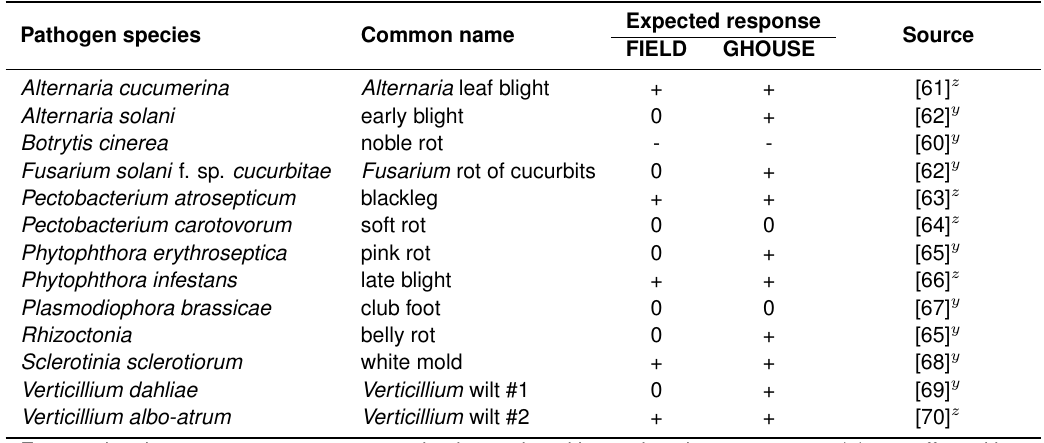
Expected pathogen responses are categorized as reduced in number due to treatment (+), not affected by treatment (0) or stimulated by treatment (-). All cited studies measured pathogen response at temperatures equal to or less than those achieved at 10 cm soil depth in our FIELD and GHOUSE experiments. y Field study; z in vitro